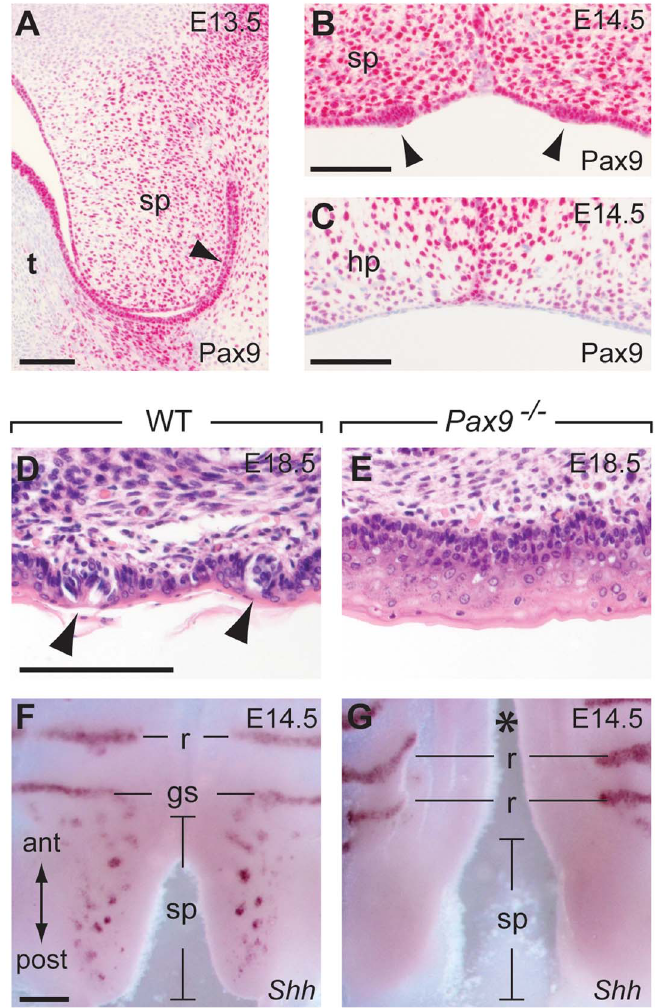
Figure 7. Pax9 is essential for taste placode formation in the soft palate. ( A–C ) Pax9 immunostaining of the secondary palate. ( A ) At E13.5, Pax9 expression is found in the mesenchyme as well as in those epithelial cells (arrowhead) of the soft palate (sp) facing the oral cavity after palatal shelf elevation. ( B ) At E14.5 the palatal shelves have elevated and Pax9 expression is seen in epithelial placodes (arrowheads) of the soft palate. ( C ) Pax9 is not expressed in the epithelium of the hard palate (hp). ( D,E ) Histological staining revealed taste bud precursors in wild type (D), but not in the Pax9 -deficient (E) epithelium of the soft palate at E18.5. ( F,G ) Whole-mount Shh in situ hybridization at E14.5. In the wild type soft palate (F), Shh expression marks the taste placodes of the soft palate as well as the ‘‘Geschmacksstreifen’’ (gs). Note that palatal rugae (r) also express Shh at this stage. (G) Shh expression is not detectable in the soft palate of Pax9 mutants, which also form a cleft secondary palate (asterisk). Scale bars: 100 m m in A–D; 200 m m in